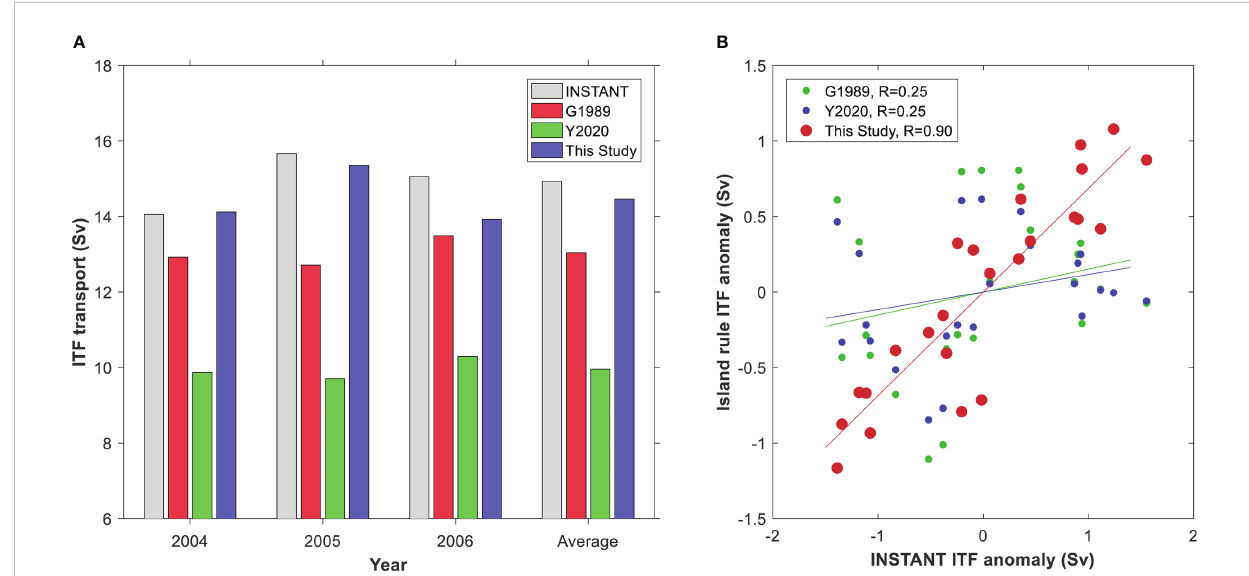
FIGURE 8 (A) Annual mean ITF transports calculated by the island rule theory and measured by the INSTANT program. (B) Comparison between 13-month running mean anomalies of ITF transport from island rule theory and the INSTANT observations. “ R ” in the right panel denotes the correlation coef fi cients between island rule ITF and INSTANT ITF transport.